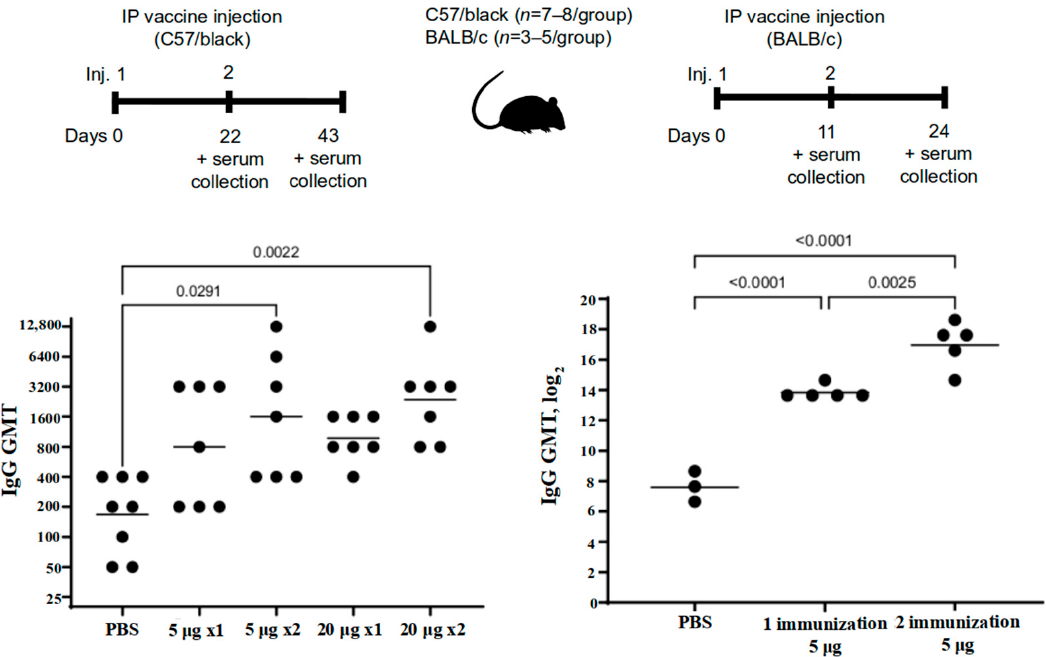
Figure 4. The level of antibodies against the SARS-CoV-2 RBD-based protein in the sera of immunized C57/black ( left ) and BALB/c ( right ) mice after a single (1 × ) or double (2 × ) intraperitoneal immunization with “Betuvax-CoV-2” at a dose of 5 µ g or 20 µ g ( left ) and 5 µ g ( right ). Separate symbols (dots) represent individual values of titers in animals; the horizontal line shows average group geometric mean titers; p < 0.05.